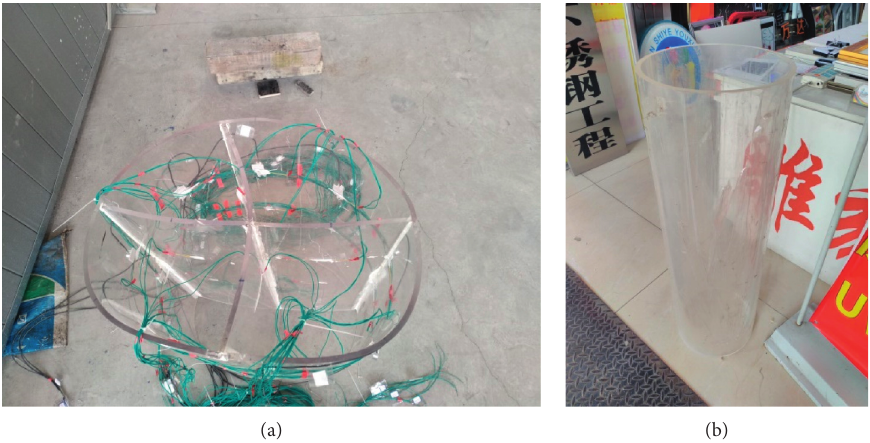
Figure 6: Acrylic tunnel model. (a) Model of the mining tunnel; (b) model of the shield tunnel.